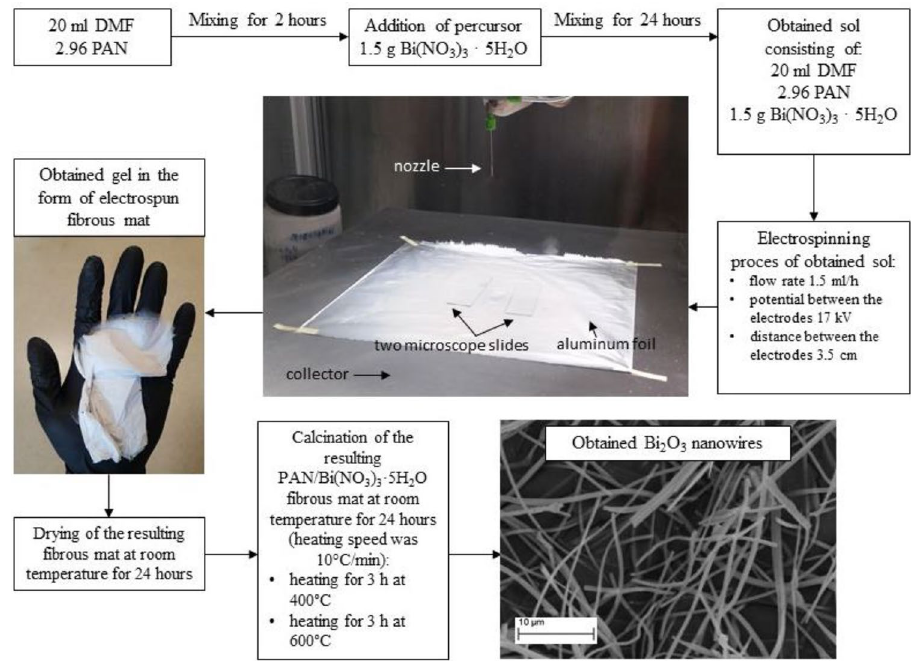
Figure 1. Experimental procedure scheme for fabrication of Bi 2 O 3 nanostructures using sol–gel process, electrospinning and calcination